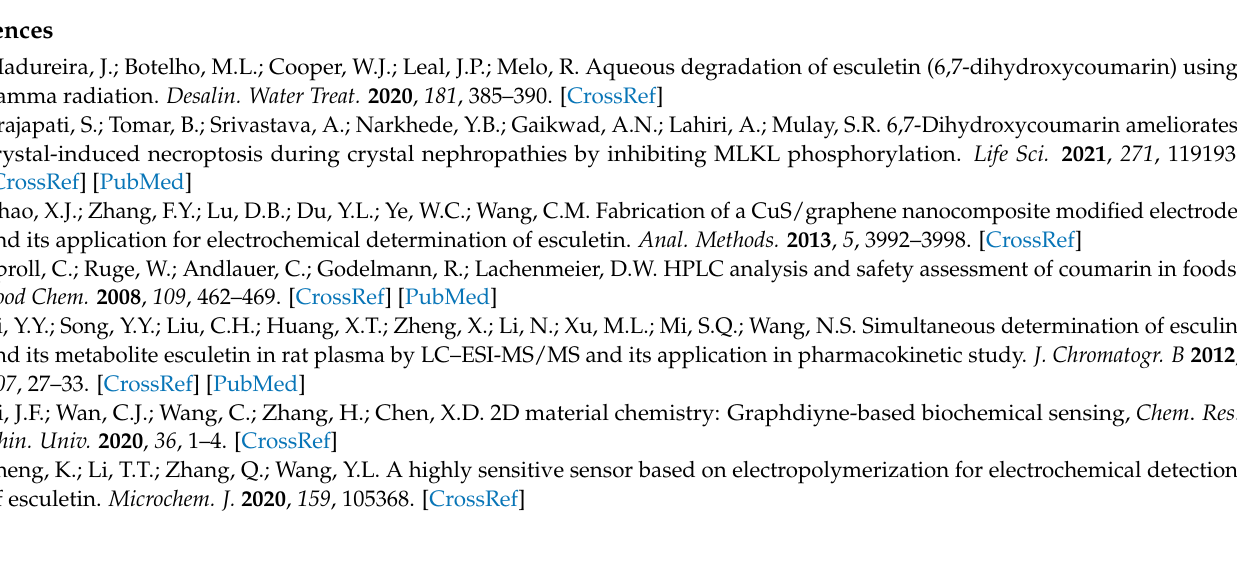
Figure S2. (A) CV curves of 0.1 mmol/L 6,7-DHC in 0.1 mol/L pH 3.0 PBS on ND@BP/SPE at different scan rates (from a to k: 0.05, 0.1, 0.2, 0.3, 0.4, 0.5, 0.6, 0.7, 0.8, 0.9, 1.0 V/s). (B) Linear relationship of Ip versus υ (n = 3). (C) Linear relationship of Ep versus ln υ (n = 3); Figure S3. (A) CV curves of 0.1 mmol/L 6,7-DHC in 0.1 mol/L pH 3.0 PBS on ND@BP/SPE at different pH values (from a to e: 2.0, 3.0, 4.0, 5.0, and 6.0) at the scan rate of 100 mV/s; (B) The relationship between E 0 (cid:48) versus pH (a) and the plot of Ipa versus pH (b) (n =